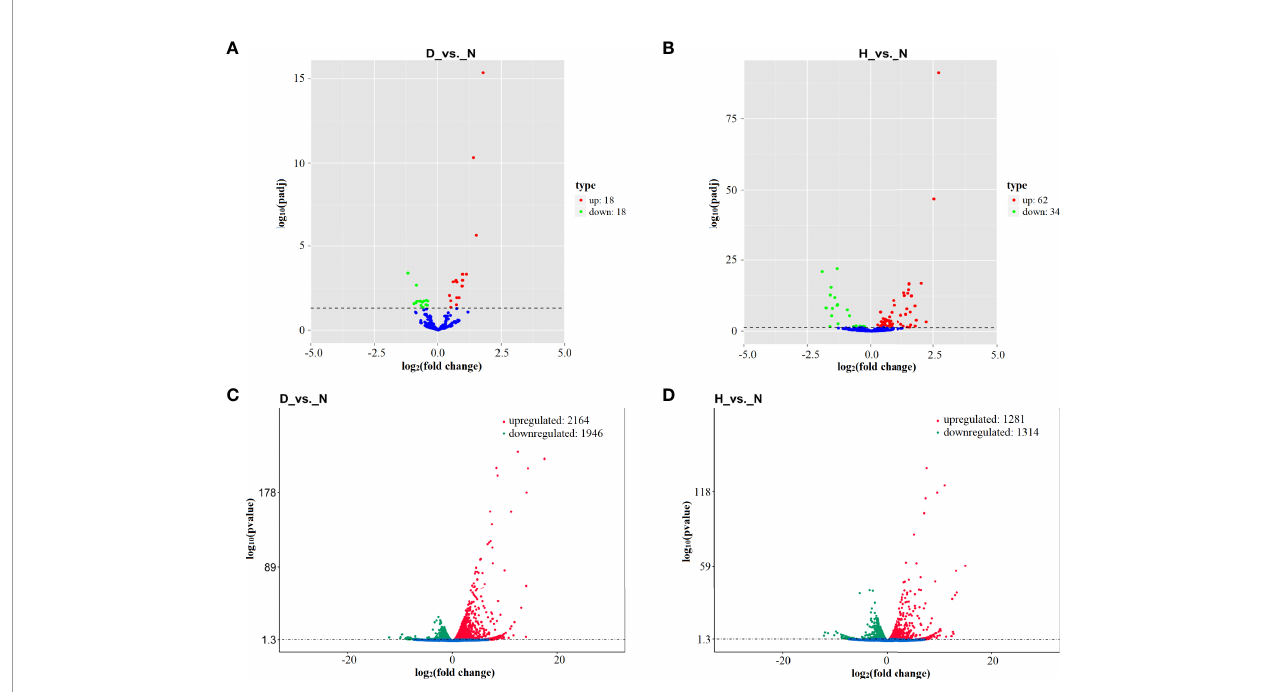
FIGURE 3 | Volcano plot of differential expression (DE) miRNAs in D-vs.-N comparison (A) and H-vs.-N comparison (B) . Volcano plot of DE mRNAs in D-vs.-N comparison (C) and H-vs.-N comparison (D) . The Log2 (fold change) is shown on the X-axis, and the – log10 (P-value) is shown on Y-axis. Red points are upregulated and green points are